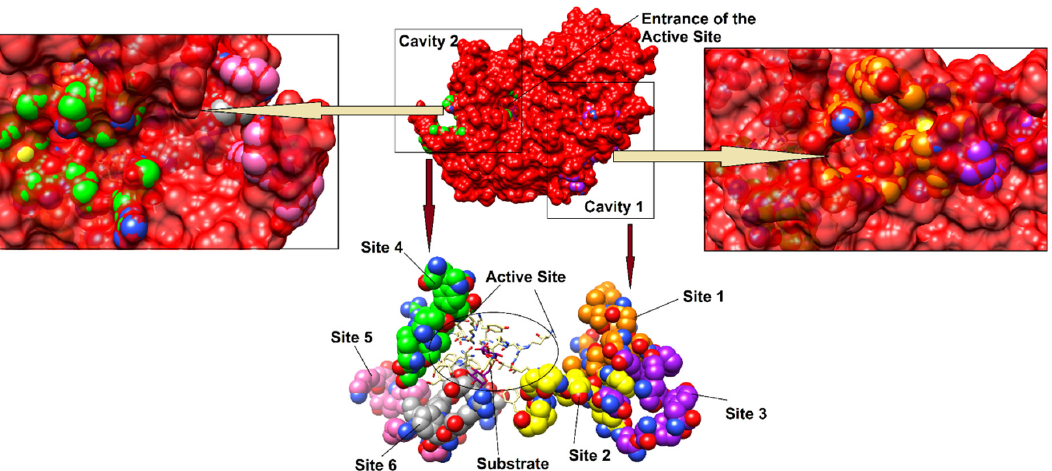
Figure 7. Structural topology of S. cerevisiae α -glucosidase is shown. The generated cavities are displayed in boxes. The predicted allosteric sites are shown in sphere model, each site is labeled. The active site residues (shown in yellow sticks) are presented in complex with the substrate molecule (isomaltose, shown in purple sticks).